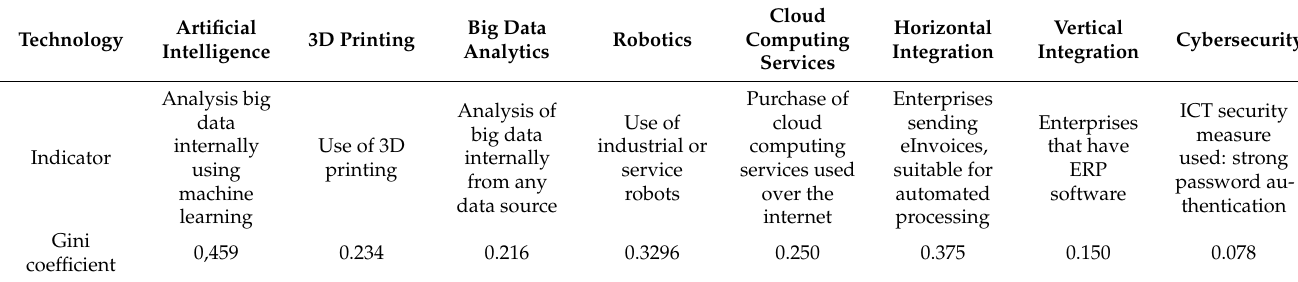
Table 5. The value of the Gini coefficient for the use of Industry 4.0 technologies in the EU